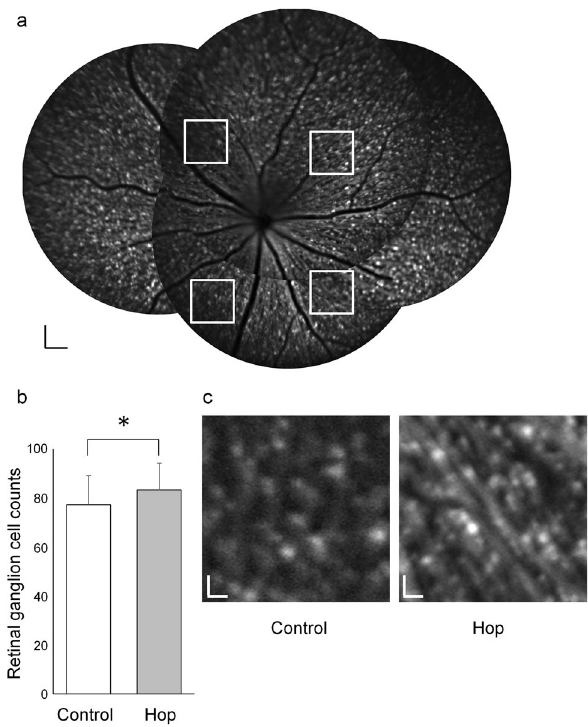
Figure 2. Prevention of retinal ganglion cell decrease in GLAST (+/−) mice administered with hop extracts, shown on SLO images. ( a ) Montage scanning laser ophthalmoscope (SLO) image of 12-month-old GLAST (+/−):Thy1-CFP mice. CFP positive retinal ganglion cells were manually counted in a masked fashion within 186 μm squares (white squares), at a distance of 456 μm from the disc center, in four directions. ( b ) Ganglion cell counts of 12-month-old GLAST (+/−):Thy1-CFP mice administered with hop extracts or water as a control. *p ≤ 0.05, unpaired t -test, n = 26 and 24 eyes in the hop-treated and control groups, respectively. ( c ) Representative images of counted squares of 12-month-old GLAST (+/−):Thy1-CFP mice administered with hop extracts or water as a control. Bars represent 100 µm in ( a ) and 20 µm in ( c